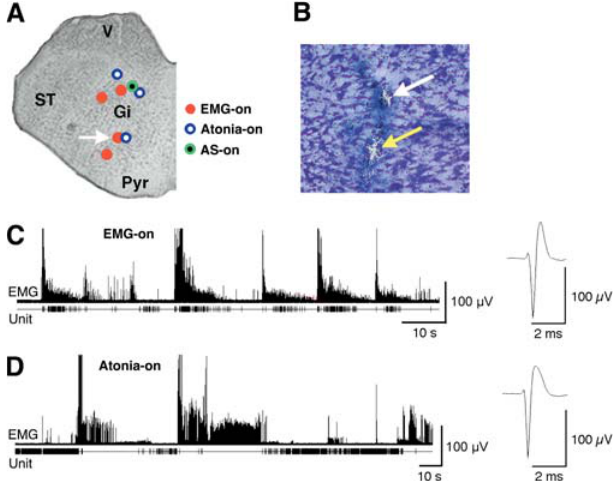
Figure 4. State-Dependent Neural Activity within Nucleus Gigantocellu- laris (A) Recording sites of state-dependent neurons reconstructed on a coronal section of the medulla of a P8 rat. Note the anatomical overlap of the different classes of neurons. Arrow corresponds to top arrow in (B). (B) Photomicrograph depicting two marking lesions in nucleus gigantocellularis (the two lesions are approximately 80 l m apart). The white arrow indicates the location of the recording site identified by the arrow in (A). (C) Lower trace: single unit activity of a representative Gi EMG-on neuron. Upper trace: concurrently recorded nuchal EMG. Far right: Averaged waveform of representative EMG-on neuron. (D) Lower trace: single unit activity of a representative Gi atonia-on neuron. Upper trace: concurrently recorded nuchal EMG. Far right: Averaged waveform of representative atonia-on neuron. Gi, nucleus gigantocellularis; Pyr, pyramids; ST, spinal trigeminal nucleus; V, vestibular nucleus DOI: 10.1371/journal.pbio.0030143.g004